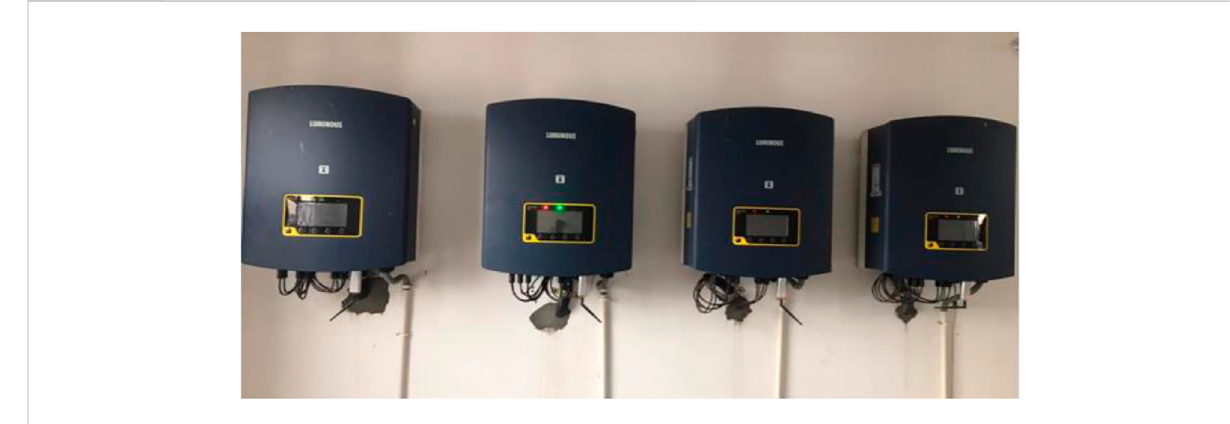
FIGURE 3 Hardware setup of the inverters.